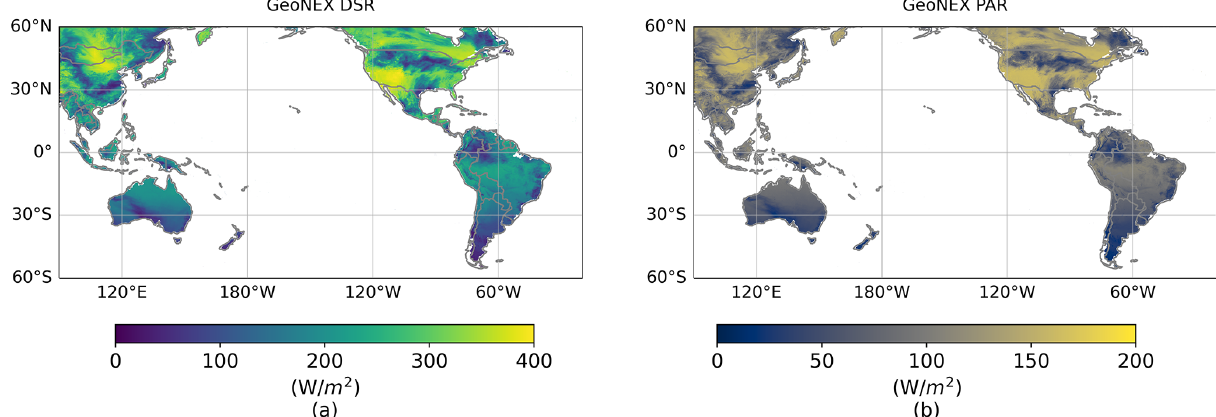
Figure 3. The daily DSR (a) and PAR (b) maps from the GeoNEX product on 19 June 2018.